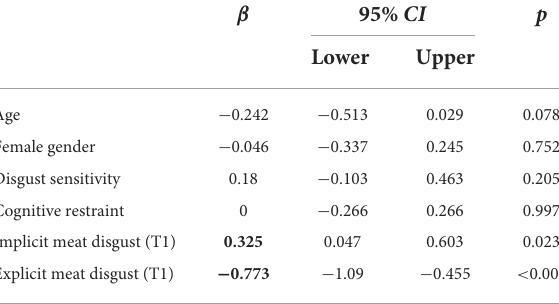
TABLE 2 Coefficients from multiple regression on baseline meat intake with six predictors.